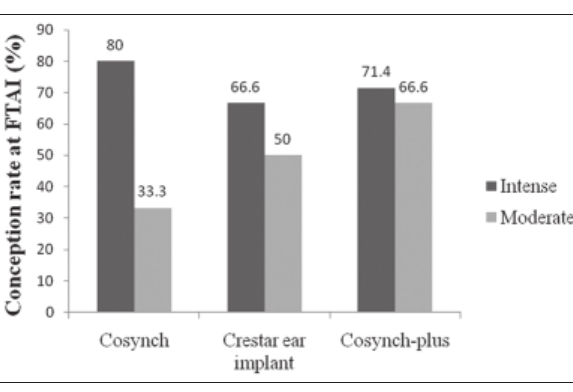
Figure-1: Comparative conception rate depending on intensity of estrus following different estrous synchronization protocols in